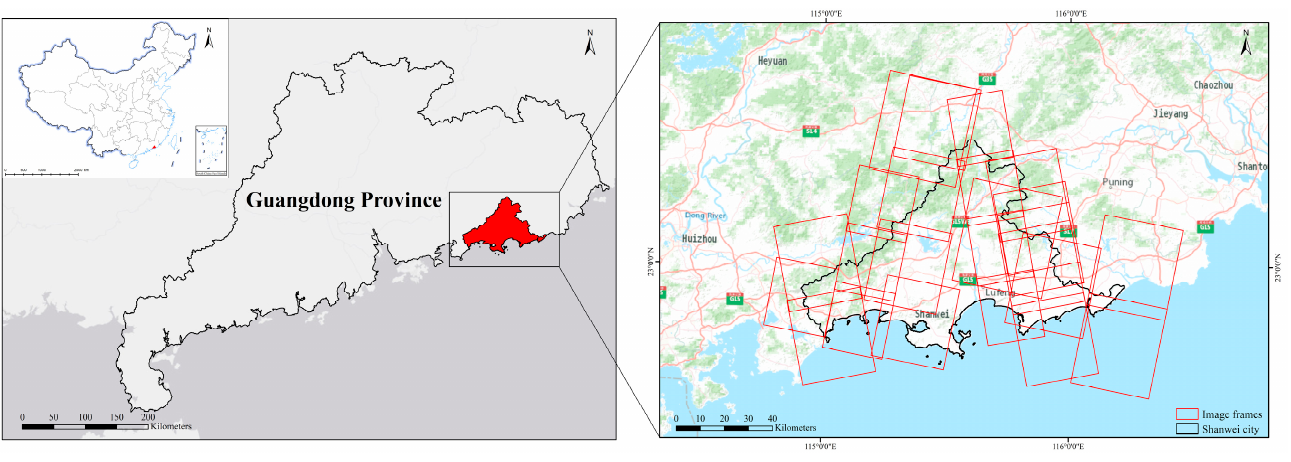
Figure 1. Image coverage in Shanwei city, Guangdong Province, China.